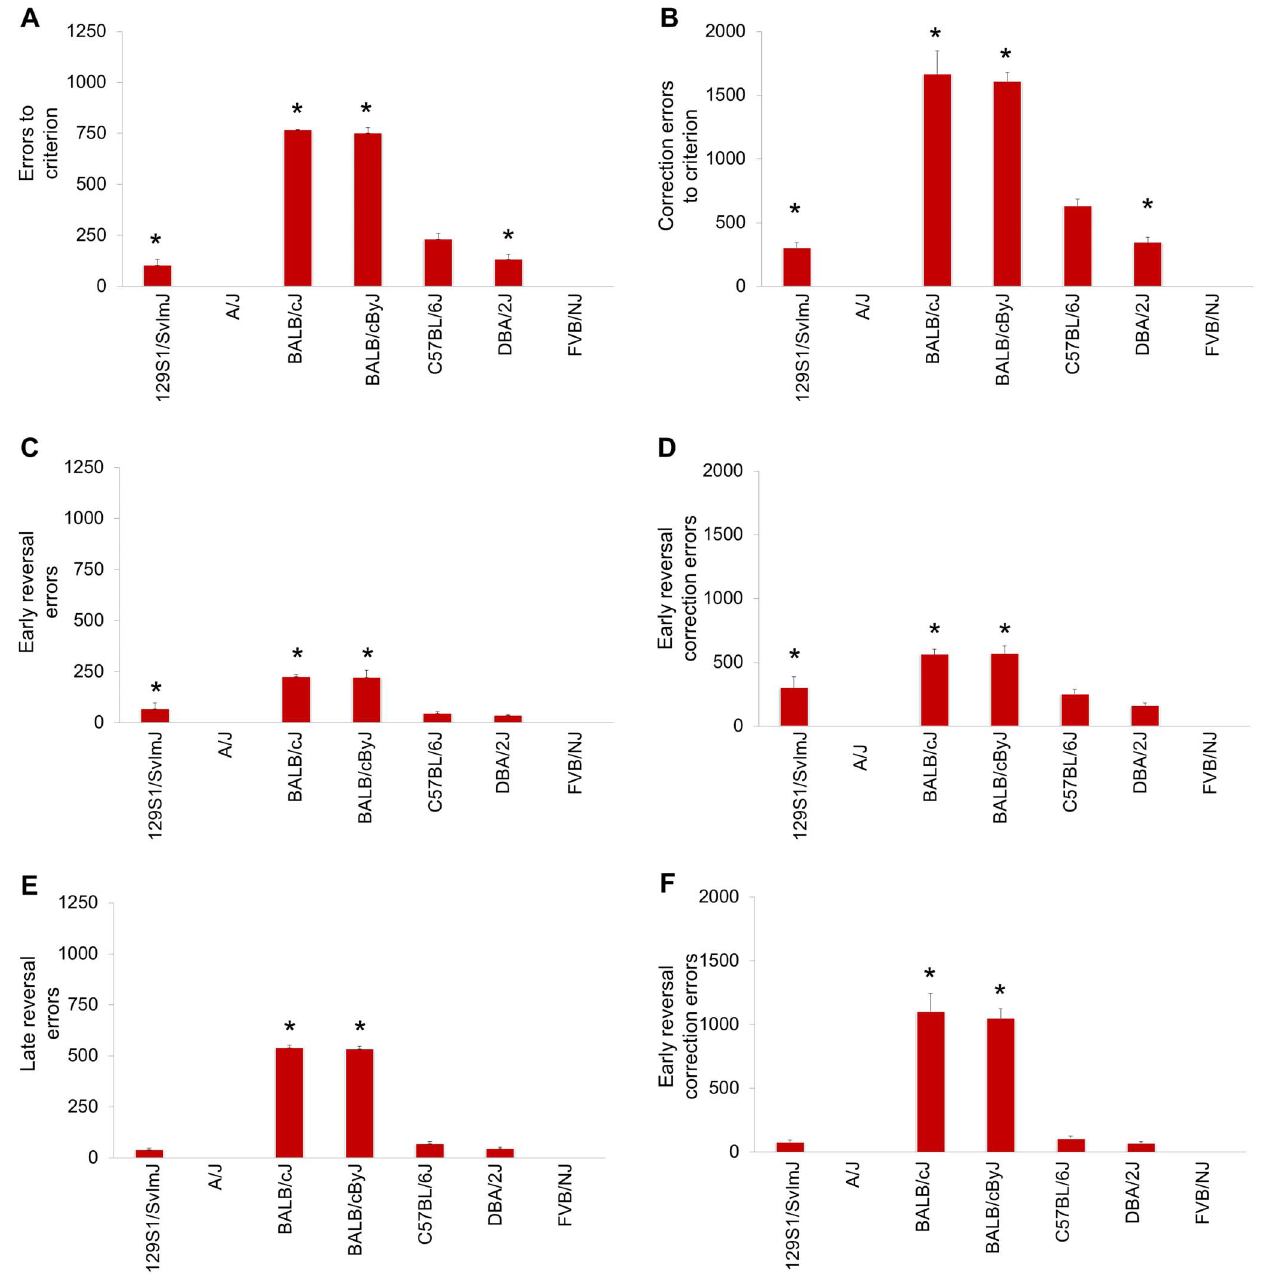
Figure 2. Inbred strain differences in reversal learning. Errors ( A ) and correction errors ( B ) to reversal criterion. Errors ( C ) and correction errors ( D ) made during early reversal. Errors ( E ) and correction errors ( F ) made during late reversal. * P , 0.5 relative to C57BL/6J. n=2–27 per strain. Data are Means 6 SEM.